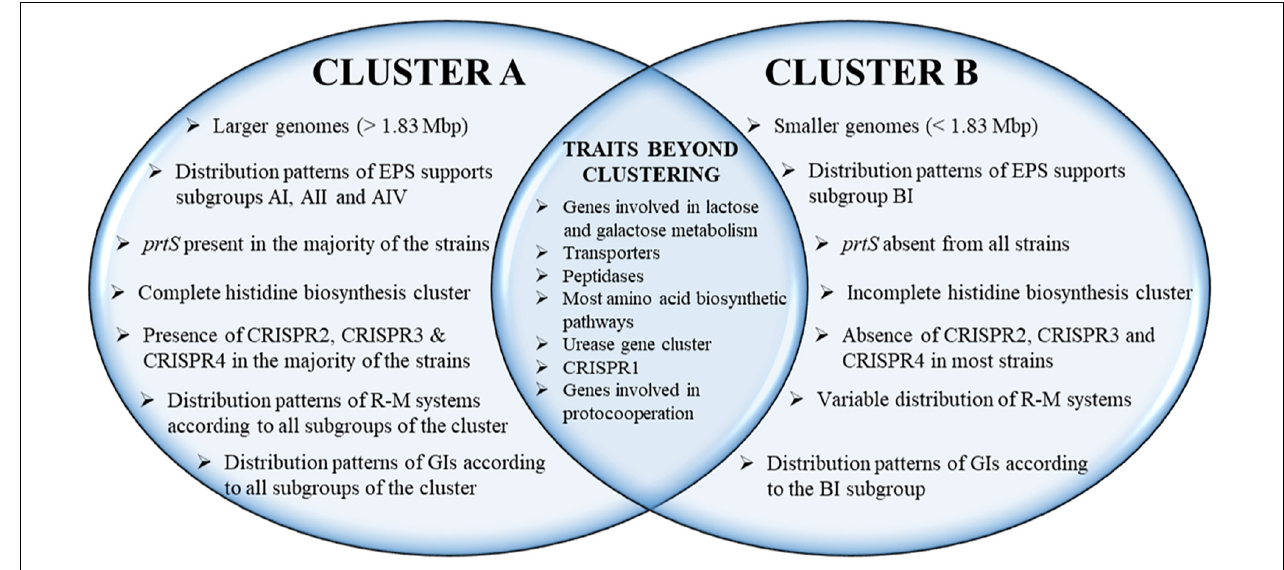
FIGURE 8 | Schematic representation of structural and functional genomic traits that support the distinction of S. thermophilus strains in clusters A and B. The genomic features included in the common area of the Venn diagram are either present to all strains or they exhibit a presence/absence pattern beyond clusters A and